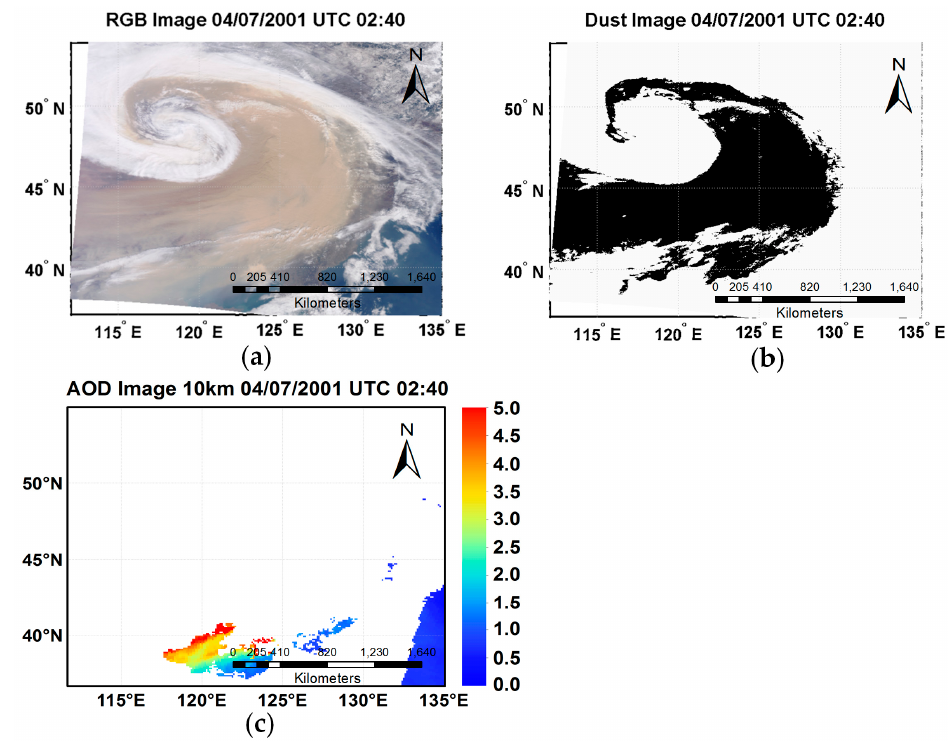
Figure 7. Dust storm in the Northeastern China on 7 April 2001. ( a ) MODIS true color image; ( b ) dust image; and ( c ) Aerosol Optical Depth (AOD) image.